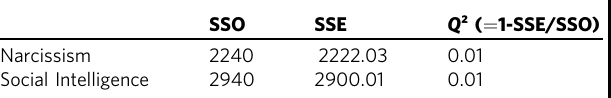
Table 7 Predictive relevance ( Q 2